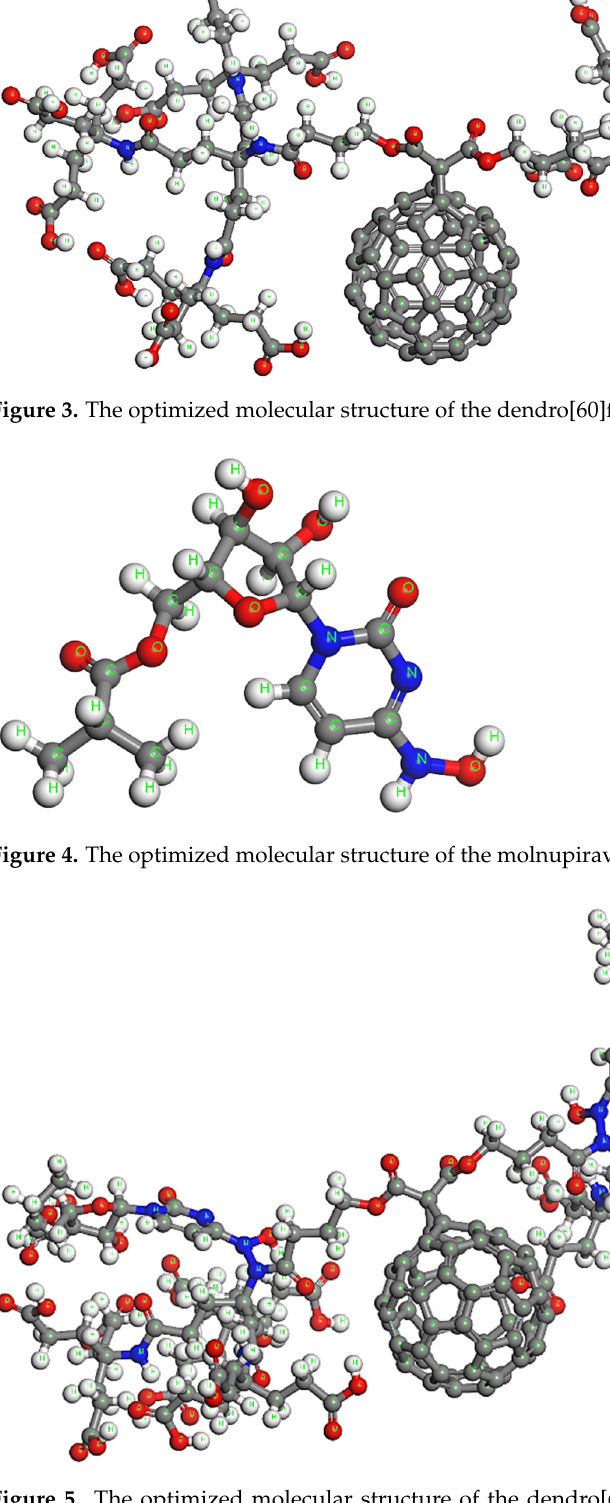
Figure 5. The optimized molecular structure of the dendro[60]fullerene with two molnupiravir molecules attached in the opposing dendrimer building blocks.